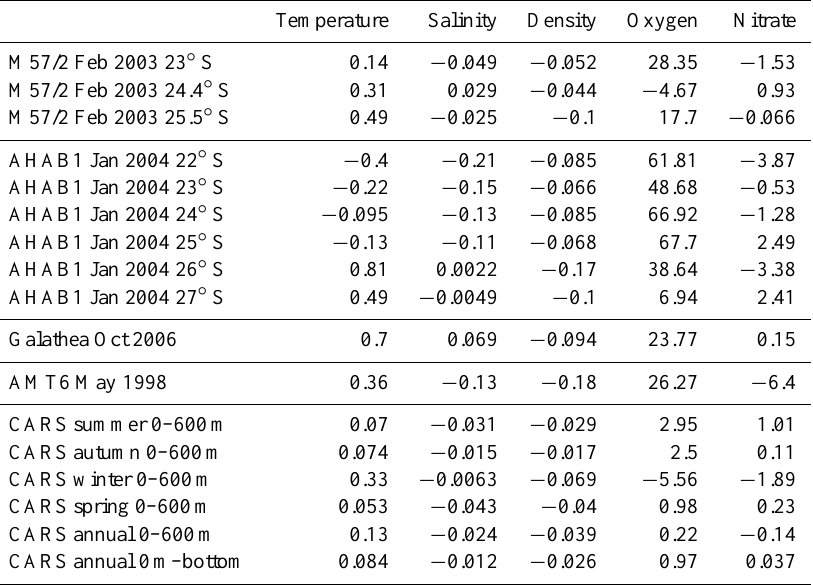
Table 3. Biases (modeled fields – data) for temperature ( ◦ C), salinity, density (kgm − 3 ) , oxygen (mmol O 2 m − 3 ) , and nitrate (mmolNm − 3 )